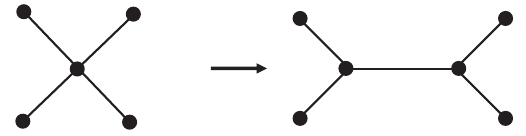
FIG. 1. Reduction of a degree-four vertex to two vertices of degree three. The vertices represent ancillas and data qubits of some topological code. By adding an additional ancilla qubit and entangling with the original ancilla, the degree of the connectivity can be reduced by